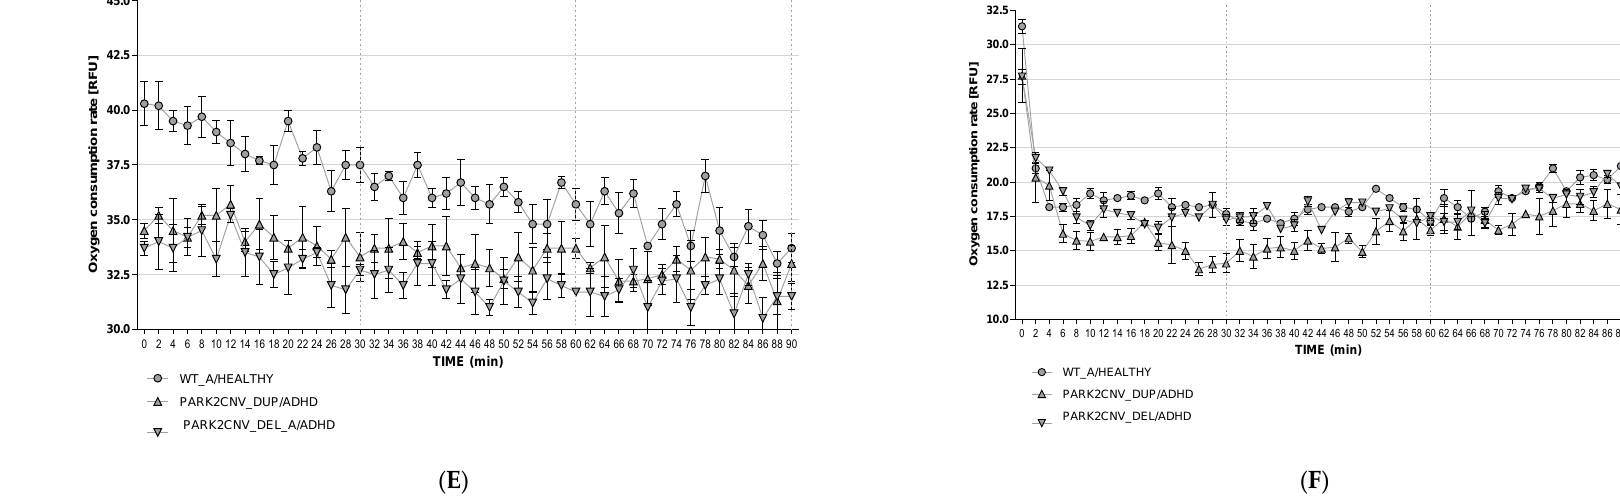
Data are shown as ± standard error of mean (SEM). Exploratory repeated measure ANOVAs and t-tests were calculated. Level of significance was set at p =